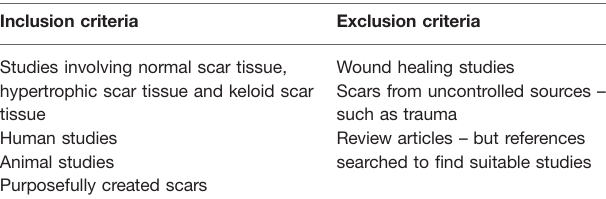
TABLE 1 | Inclusion and Exclusion criteria. Inclusion